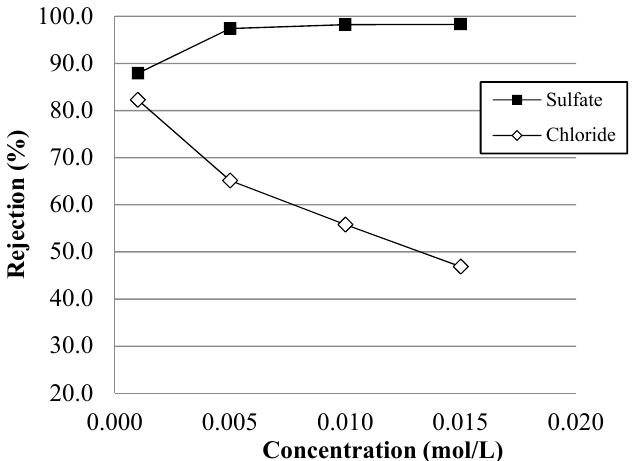
Figure 7. Effect of salt concentration on apparent sulfate and chloride rejection. Experimental conditions: feed pressure = 10 bar, 25 °C.